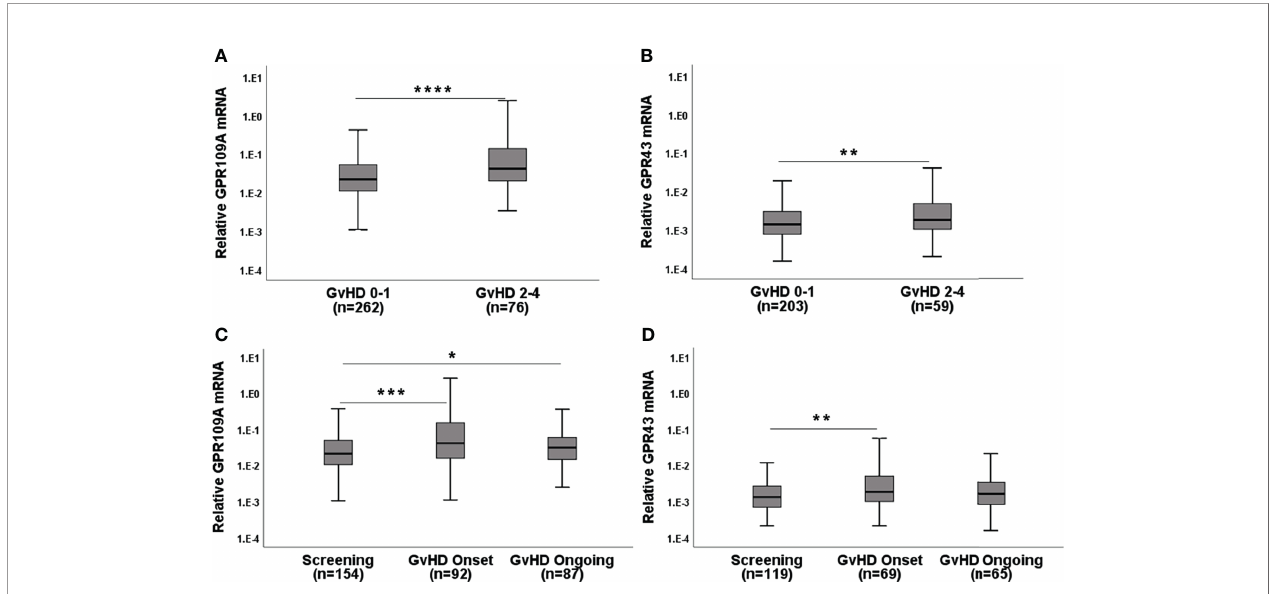
FIGURE 1 | GPR mRNA expression in the serial biopsies from the gastro-intestinal tract in the course of GvHD. (A) GPR109A and (B) GPR43 expression with respect to Lerner GI-GvHD. (C) GPR109A and (D) GPR43 expression in screening biopsies and at the clinical onset of GI-GvHD. *p < 0.05, **p < 0.01, ***p < 0.001, ****p < 0.0001, Mann-Whitney U